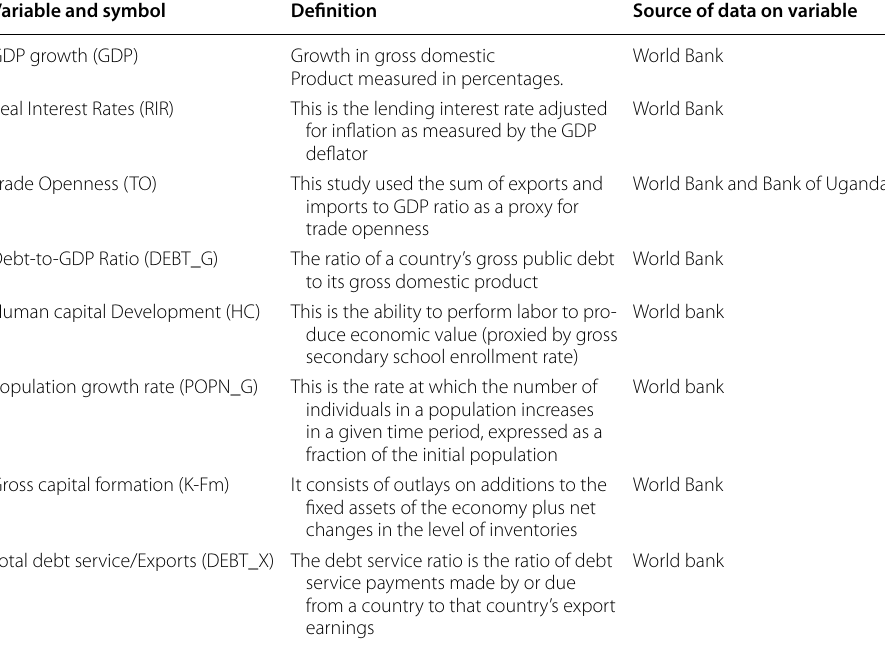
Table 1 Definition of variables and sources of data Variable and